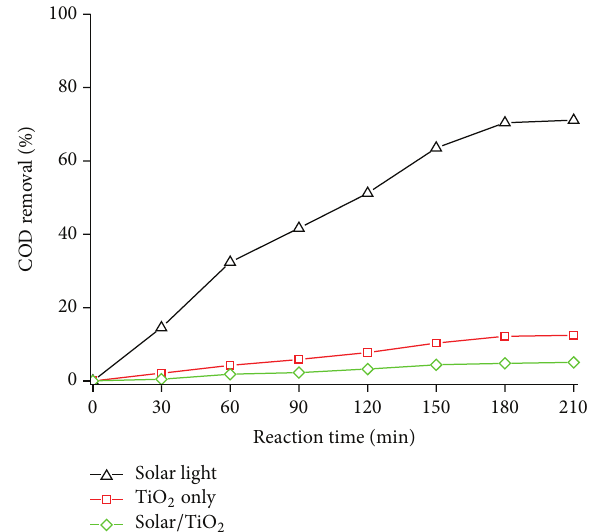
Figure 3: %COD removal during thetreatment of the wastewater by different oxidation processes against reaction time, with solar light only, with TiO 2 only, and with solar/TiO 2 [TiO 2 = 0.75 g/L, pH = 6.5]. (Figure 3 is reproduced from reference [24]. Copyright 2011, with permission from